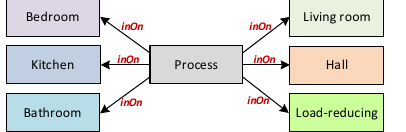
Figure 15. SHS—the CFSM model.